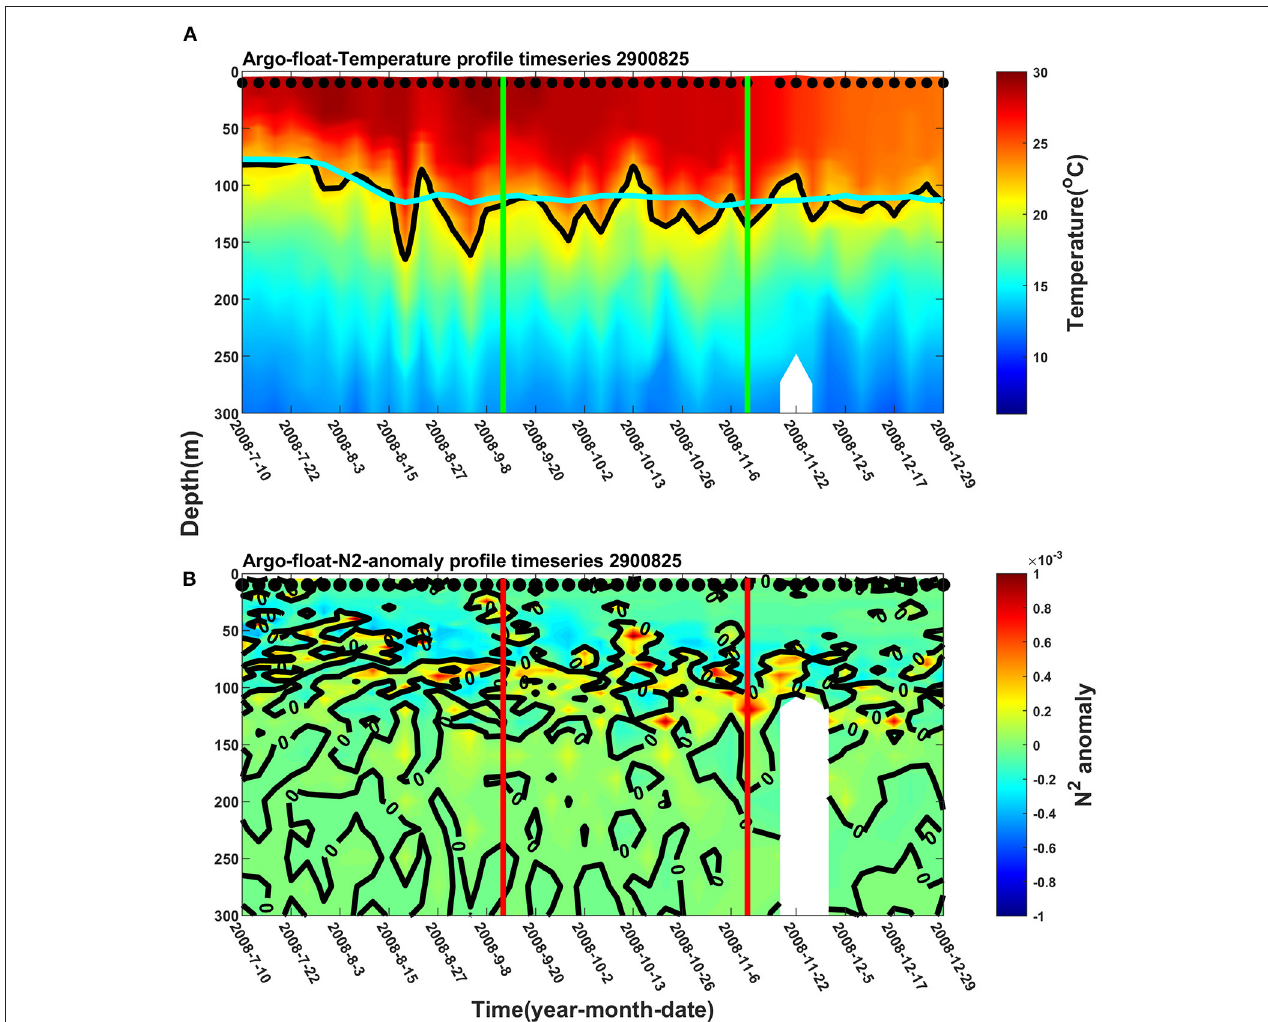
FIGURE 3 | Profiles of (A) temperature and (B) N 2 anomalies obtained from Argo 2900825 from July 10 to December 29, 2008. The two vertical lines in each subfigure show the region of anticyclonic eddy confirmed with satellite altimeters. The dots near the surface show the observed times of the Argo float.